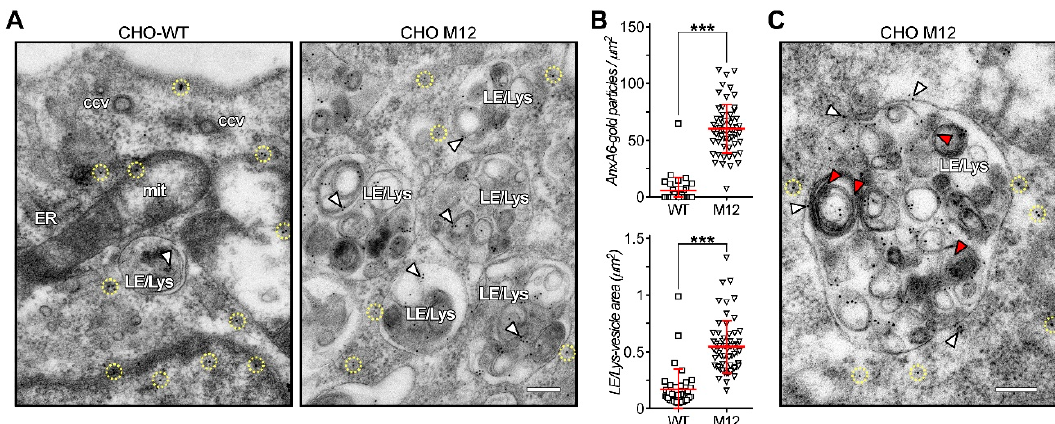
Figure 5. AnxA6 is enriched in inner membranes of the late endosome / lysosome (LE / Lys) compartment in NPC1 mutant cells. Lowicryl HM20 ultrathin sections of CHO-WT and CHO M12 cells were labeled with anti-AnxA6. ( A ) A region of the cytoplasm of CHO-WT and CHO M12 cells with several LE / Lys structures is shown. Note that in CHO M12 cells AnxA6 gold labeling is much more prominent compared to CHO-WT cells. Encircled gold particles (dashed yellow) indicate cytoplasmatic AnxA6 labeling. ( B ) Quantification of gold particle density (gold particle / µ m 2 ) and LE / Lys vesicle area ( µ m 2 ). The data is shown as dot plot per cell. The mean ± SEM is also given (*** p < 0.001). ( C ) Representative enlarged image of a prototypical endolysosome in CHO M12 cells. AnxA6 labeling is enriched in inner LE / Lys structures (red arrowheads) and less prominent at the LE / Lys perimeter (white arrowheads). mit, mitochondria; ccv, clathrin coated vesicles; ER, endoplasmic reticulum. Scale bar is 200 nm.